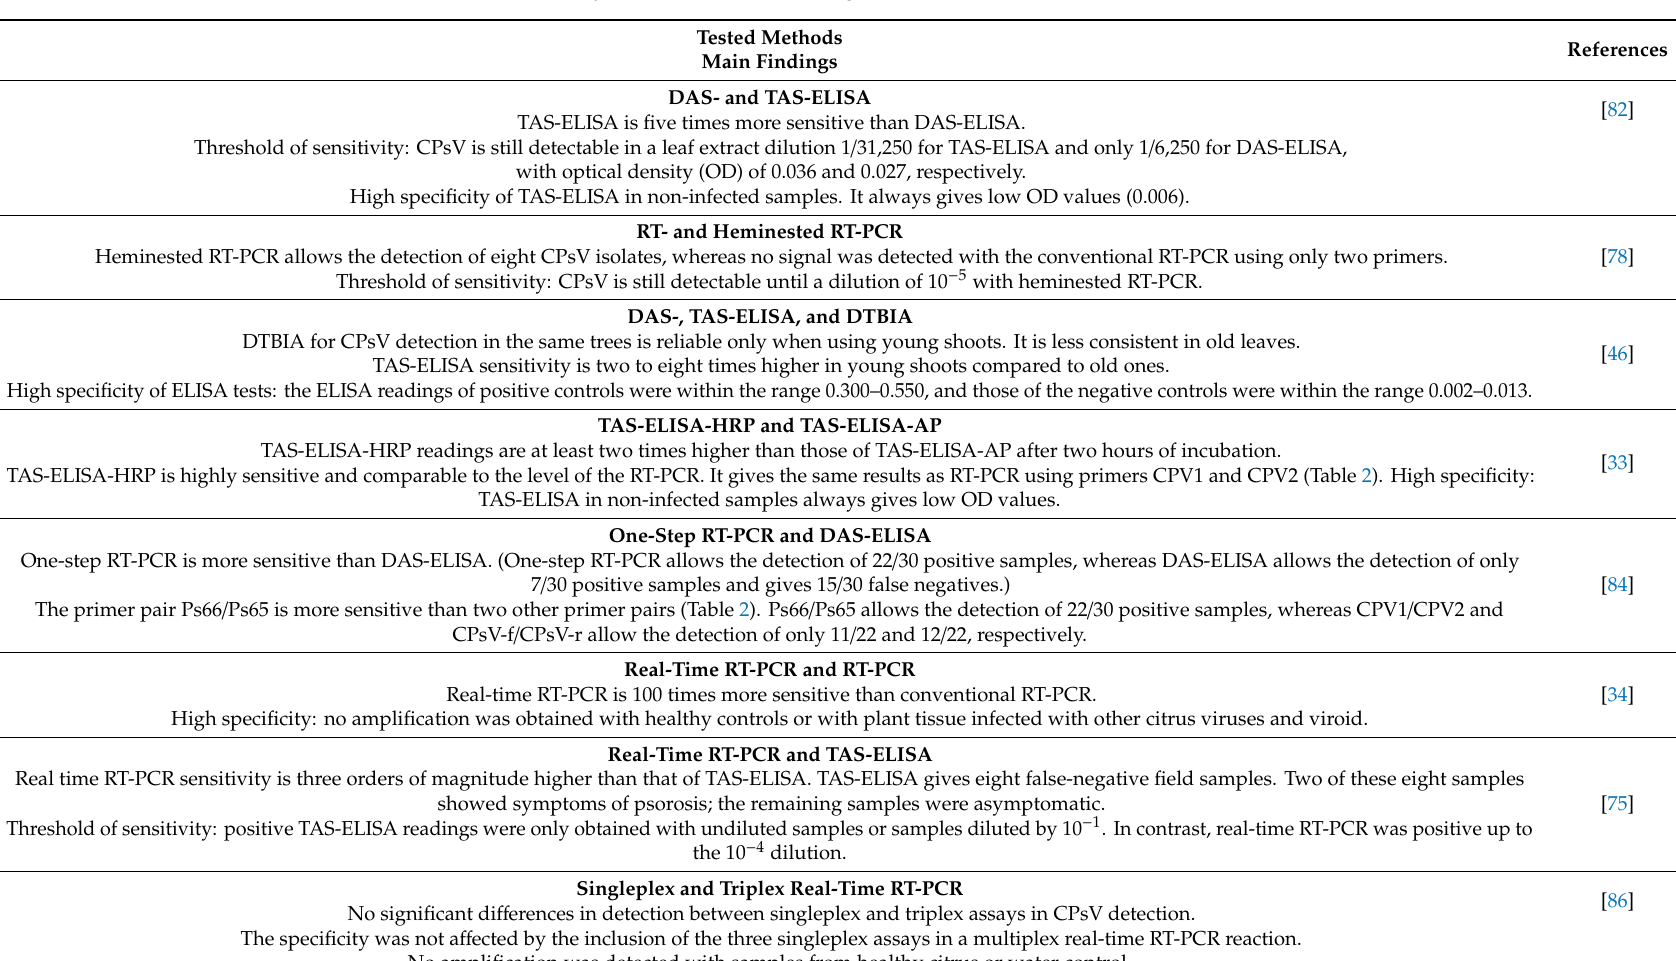
Table 1. Summary table of the main findings from the di ff erent CPsV detection